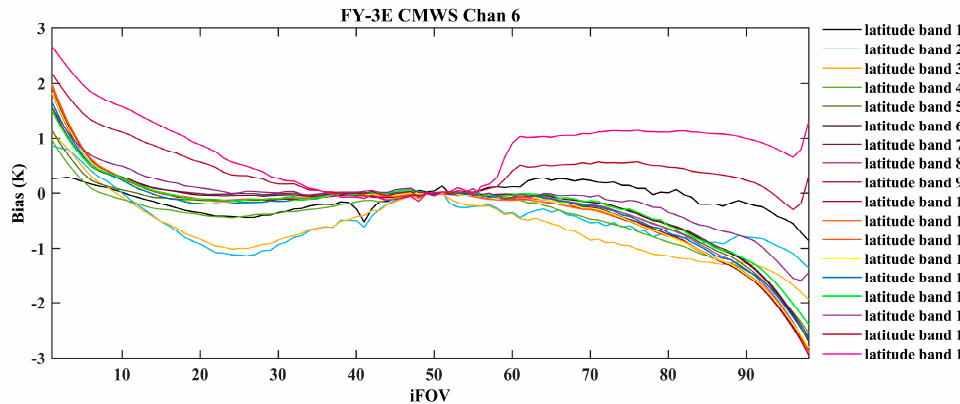
Figure 10. The scan bias for FY-3E CMWS channel 6 observation in the divided 18 latitude band. The different color indicates the different latitude band.